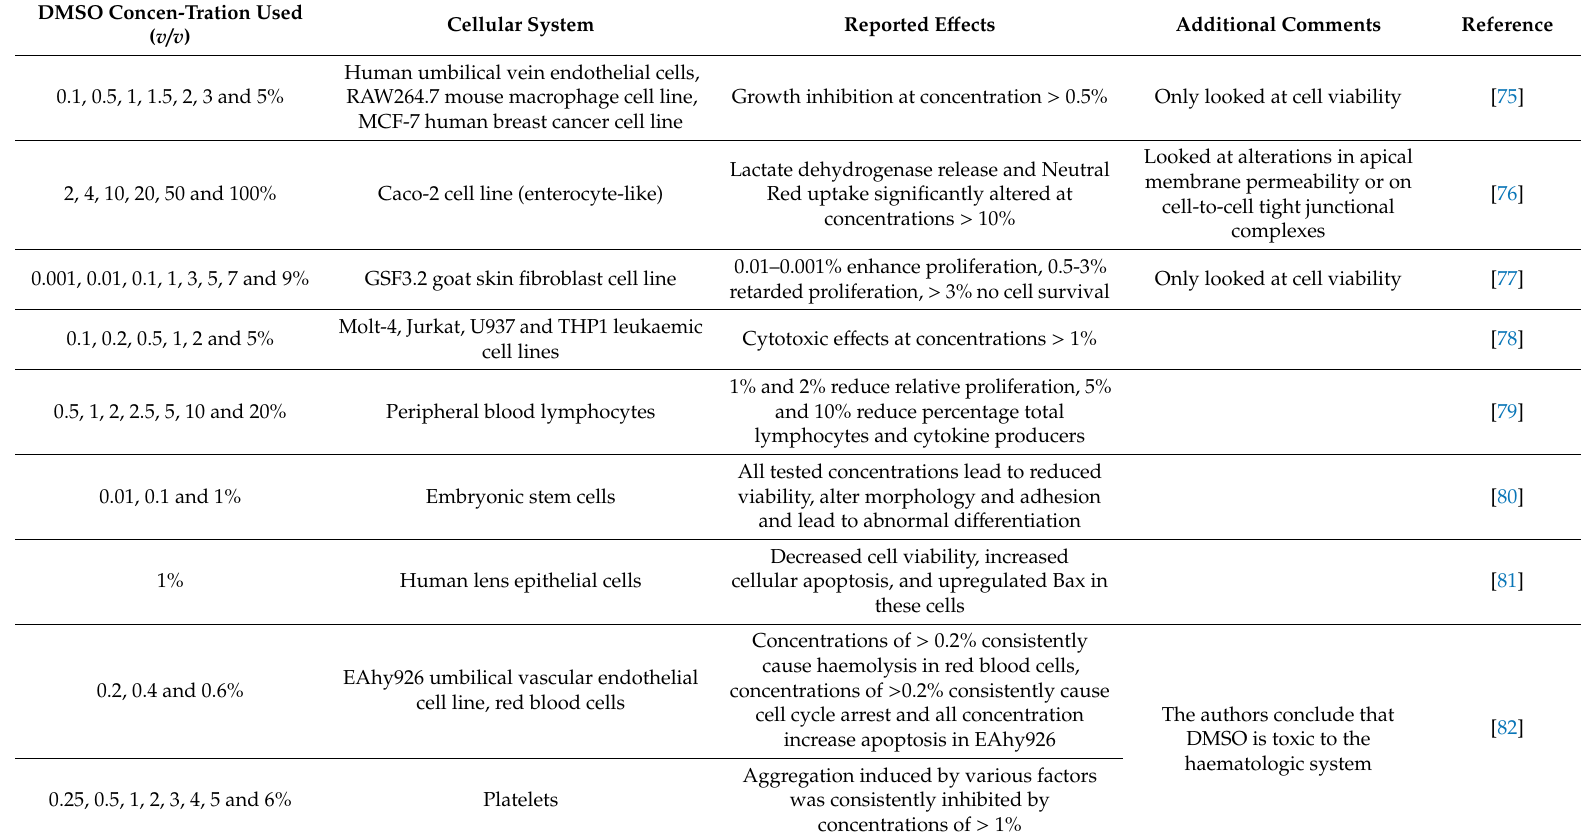
Table 2. Toxicity of Dimethyl sulfoxide (DMSO) in various cellular